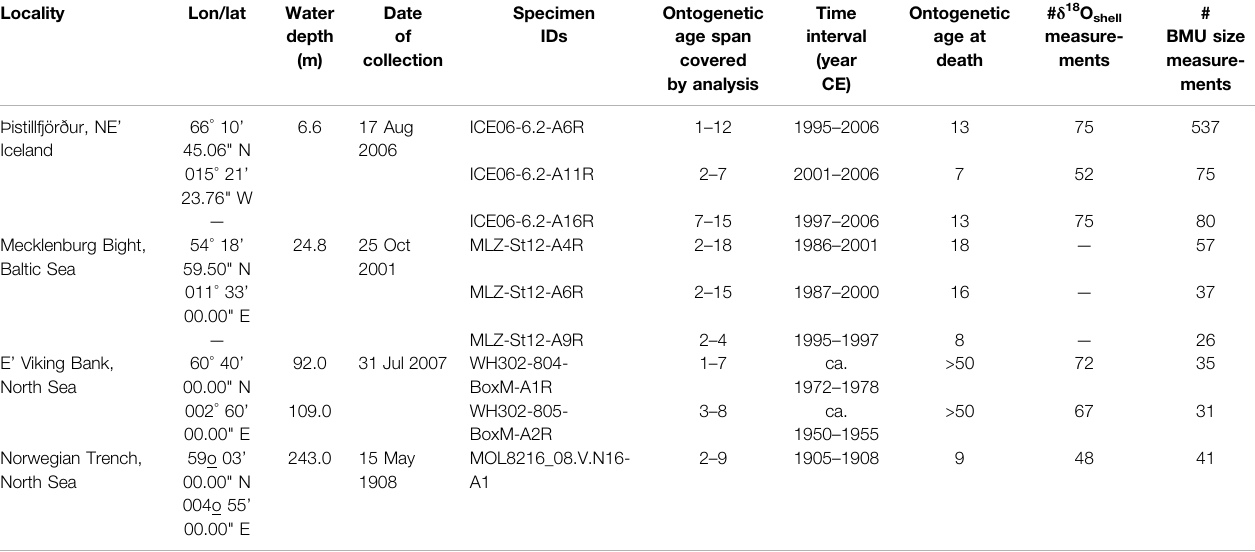
TABLE 1 | Overview of the studied Arctica islandica shells.